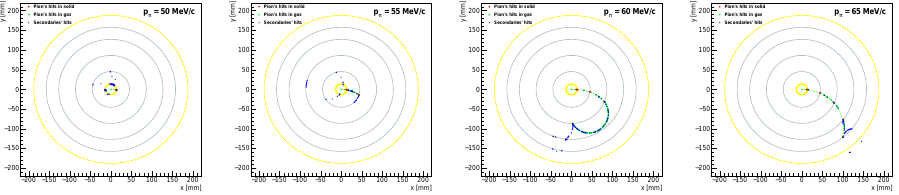
Figure 4. Cross-section of Inner Tracker based on Si-strips with hits, left by pion and secondary